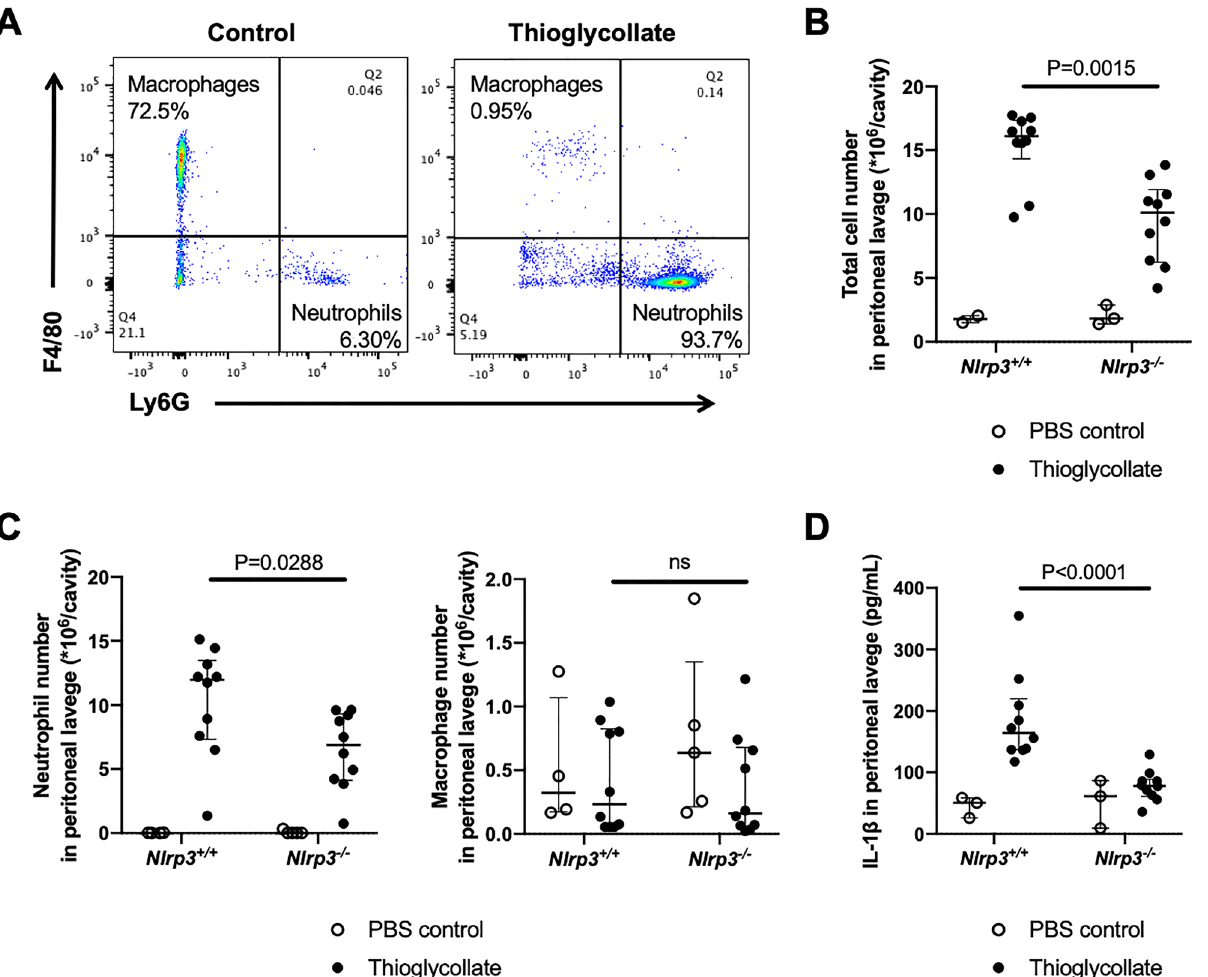
Figure 1. Nlrp3 -/- mice show less inflammatory cell recruitment and reduced levels of IL-1β in the peritoneal lavage fluid in the thioglycollate-induced peritonitis model. Mice were injected intraperitoneally (i.p.) with 1 mL sterile 3% thioglycollate broth (closed circles) or 1 mL sterile PBS (open circles). Four hours afterward, intraperitoneal cells were collected, counted, and analyzed for neutrophils and macrophages by flow cytometry. In addition, peritoneal lavage fluid was collected for cytokine measurements. ( A ) Neutrophils and macrophages in the intraperitoneal lavage fluid were defined as Ly6G-positive cells and F4/80-positive cells, respectively. ( B ) The total cell number in the peritoneal lavage fluid of Nlrp3 + / + and Nlrp3 −/− (PBS control, n = 3:3; Thioglycollate, n = 10:10). ( C ) The absolute numbers of neutrophils and macrophages in the peritoneal lavage fluid analyzed by flow cytometry (PBS control, n = 4:5; Thioglycollate, n = 10:10). ( D ) IL-1β in peritoneal lavage fluid measured by ELISA (PBS control, n = 3:3; Thioglycollate, n =